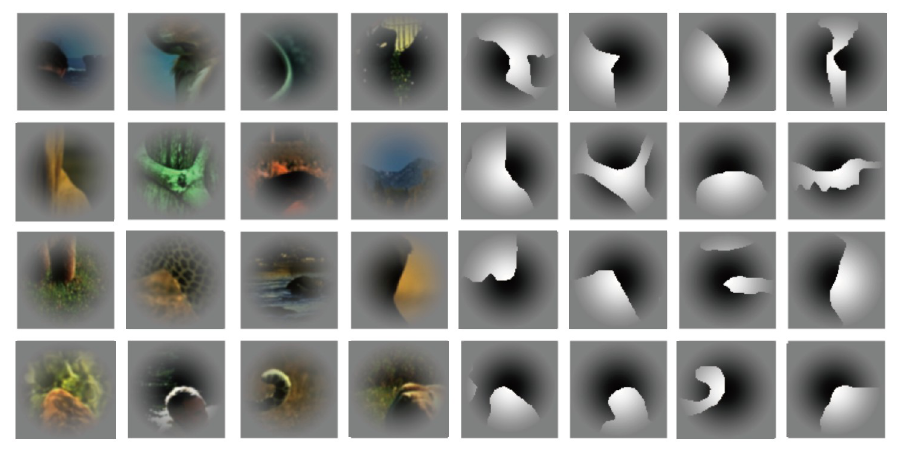
Fig 1. Examples of the natural and filled